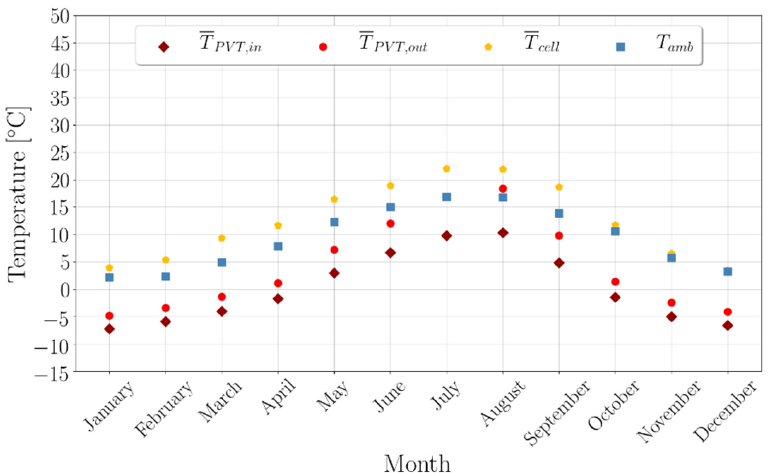
Figure 20. Monthly operating and weighted operating temperatures related to the performance of the PVT collectors. The cell temperature of the PV panel, T cell is included for reference purposes.